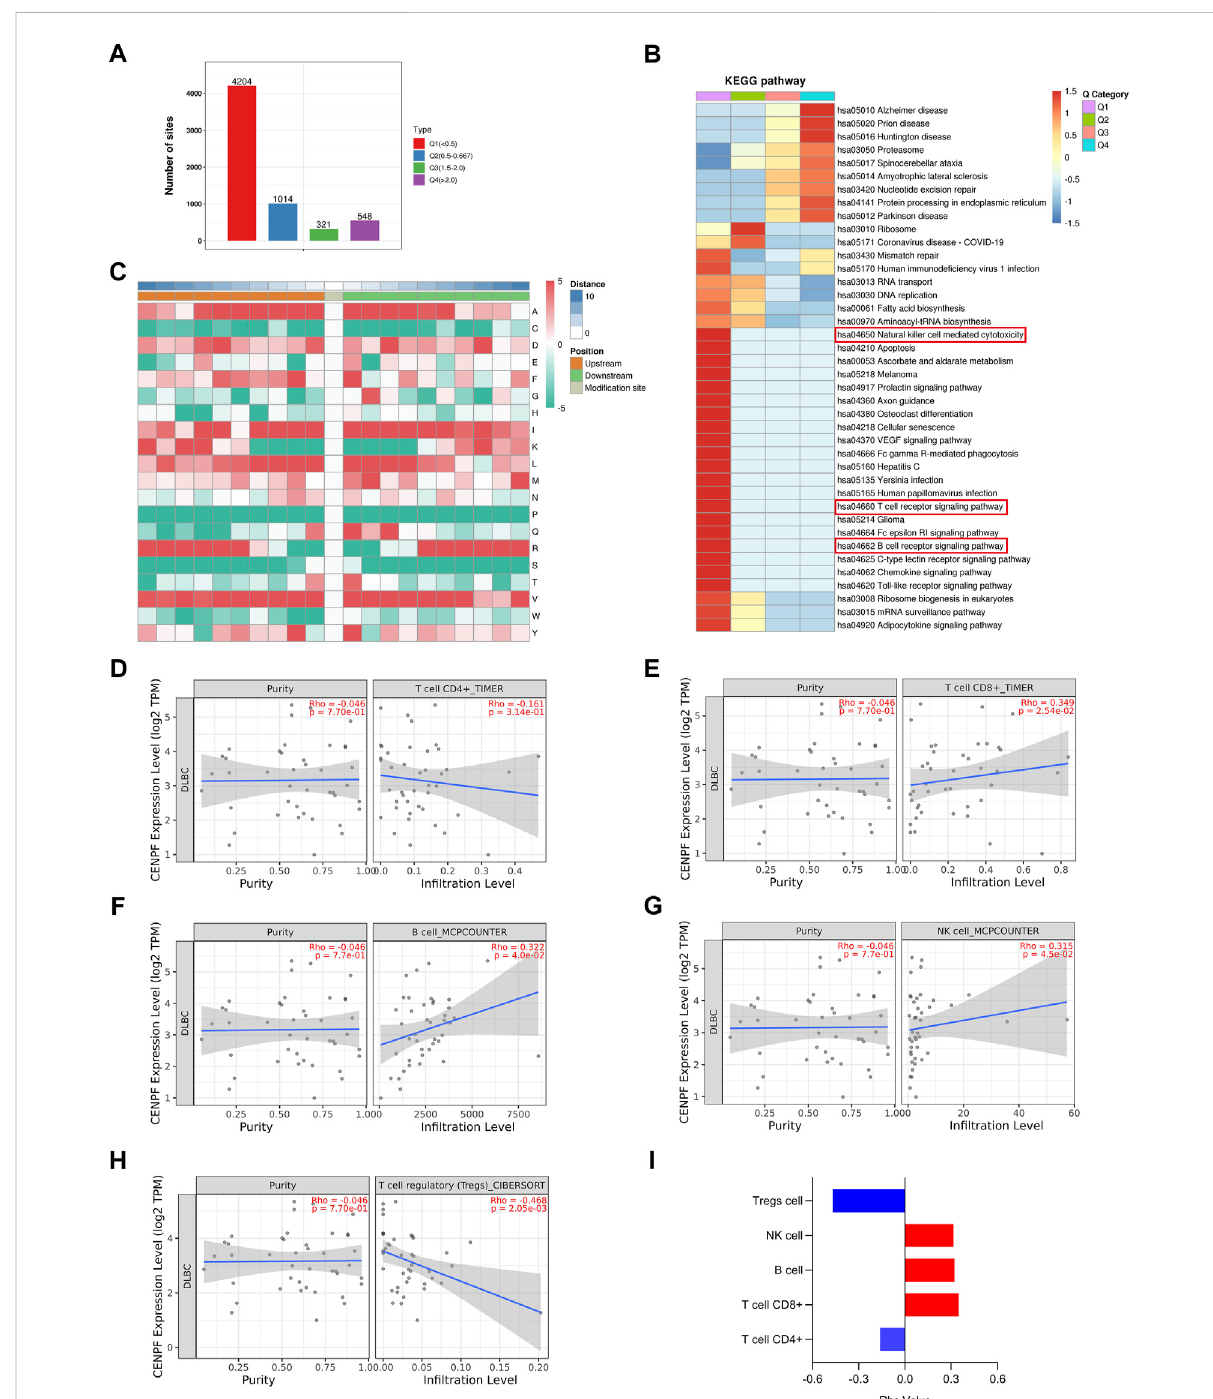
FIGURE 5 Bioinformatics analysis and immunein fi ltration evaluation in DLBCL cells (A) . The ubiquitination sites were divided into 4 parts according to the fold change in ubiquitination levels in CENPF-upregulated DLBCL cells: Part Q1 (fold change < 0.5), Part Q2 (fold change from 0.5 to 0.667), Part Q3 (fold change from 1.5 to 2.0) and Part Q4 (fold change > 2.0); (B) . The results of KEGG pathway enrichment analysis of proteins identi fi ed by ubiquitinome; (C) . The motif analysis of ubiquitination sites in this study; d-i. The role of CENPF in immune in fi ltration in DLBCL presented with CD4 + T cells, CD8 + T cells, B cells, NK cells and regulatory T cells veri fi ed using